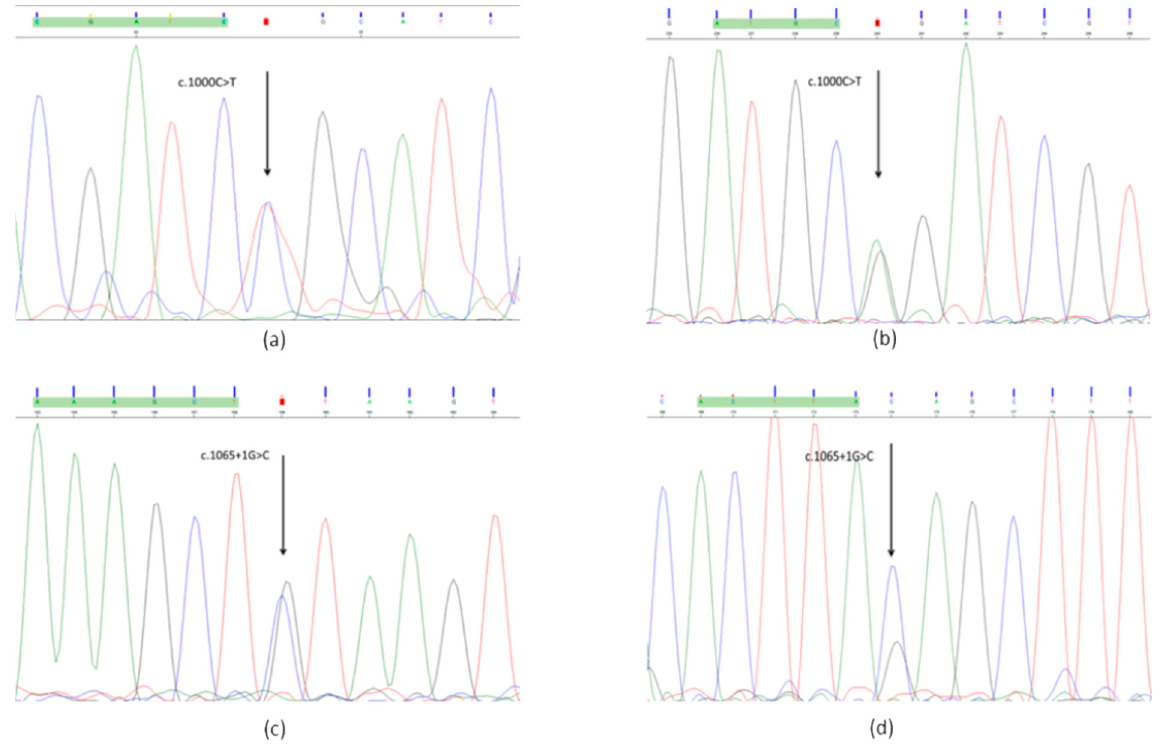
Figure 1. Sanger sequencing: ( a ) c.1000C > T forward primer; ( b ) c.1000C > T reverse primer; ( c ) c.1065 + 1 G > C forward primer; ( d ) c.1065 + 1 G > C reverse primer.